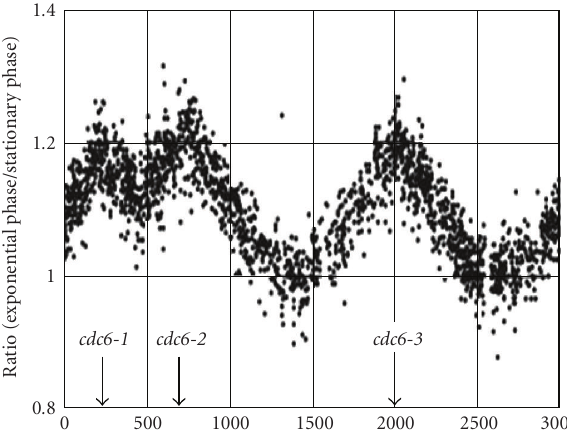
Figure 3: Marker Frequency distributions: exponential growth versus stationary phase for S. solfataricus (courtesy of Magnus Lundgren). Here DNA from S. solfataricus cells in exponential phase was compared to DNA from cells in stationary phase. Cells that just have begun growing have more copies of genes at or close to a DNA replication site than DNA further from the replication start site. Therefore genes close to a replication start site will have a higher ratio than genes not close to such a site and this is seen as a peak in the figure. The figure has three clear peaks, showing that S. solfataricus has 3 origins of replication; each peak is located near a predicted cdc6